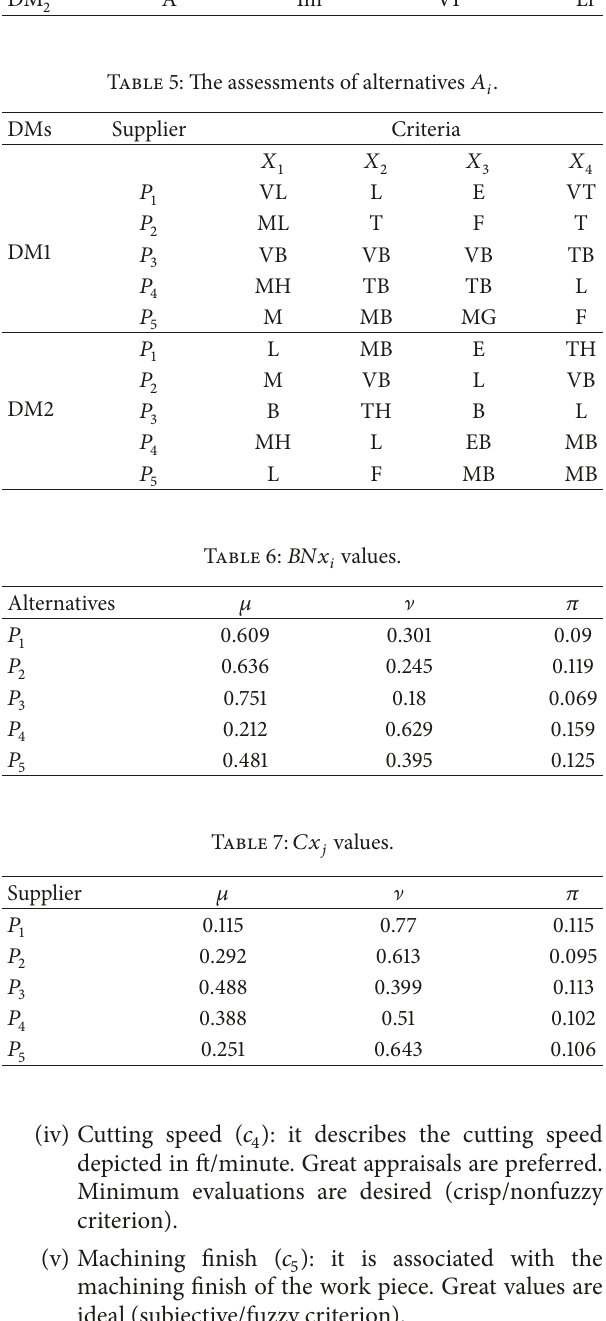
Table 9: Defuzzification of costs 𝑁𝑥 𝑗 .